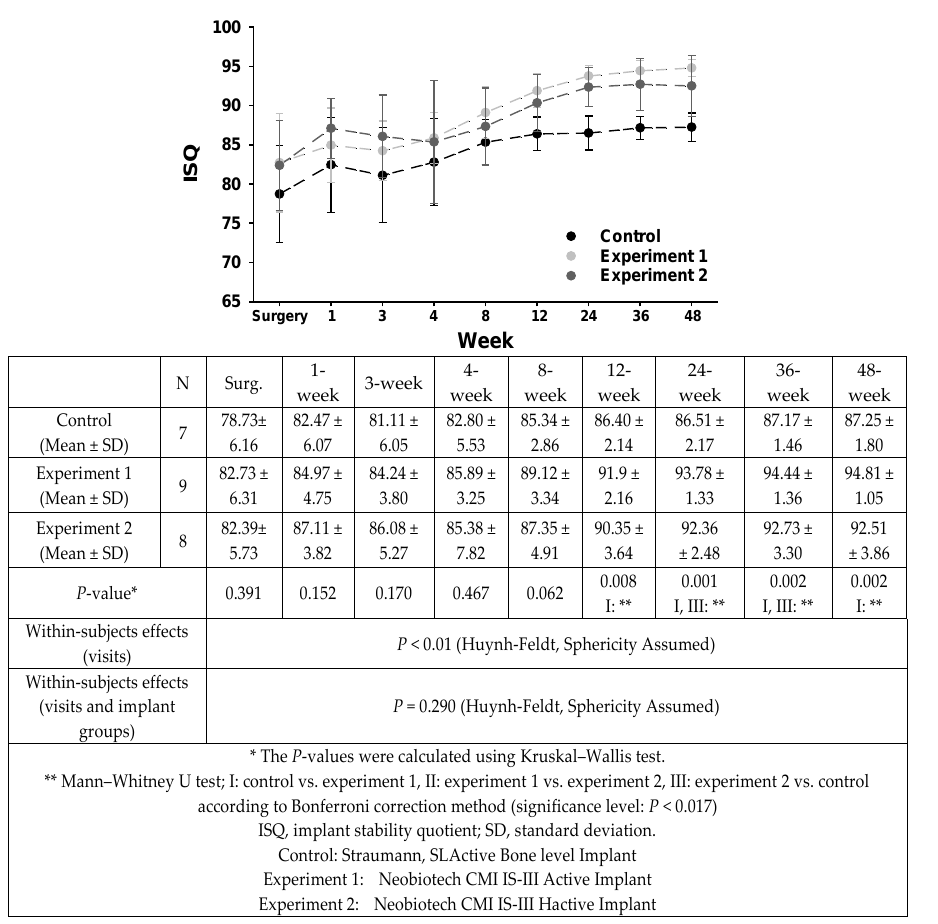
Figure 7. Comparison of stability in terms of the pattern of changes in implant stability quotients (ISQ) during the 48-week observation period after implant surgery.